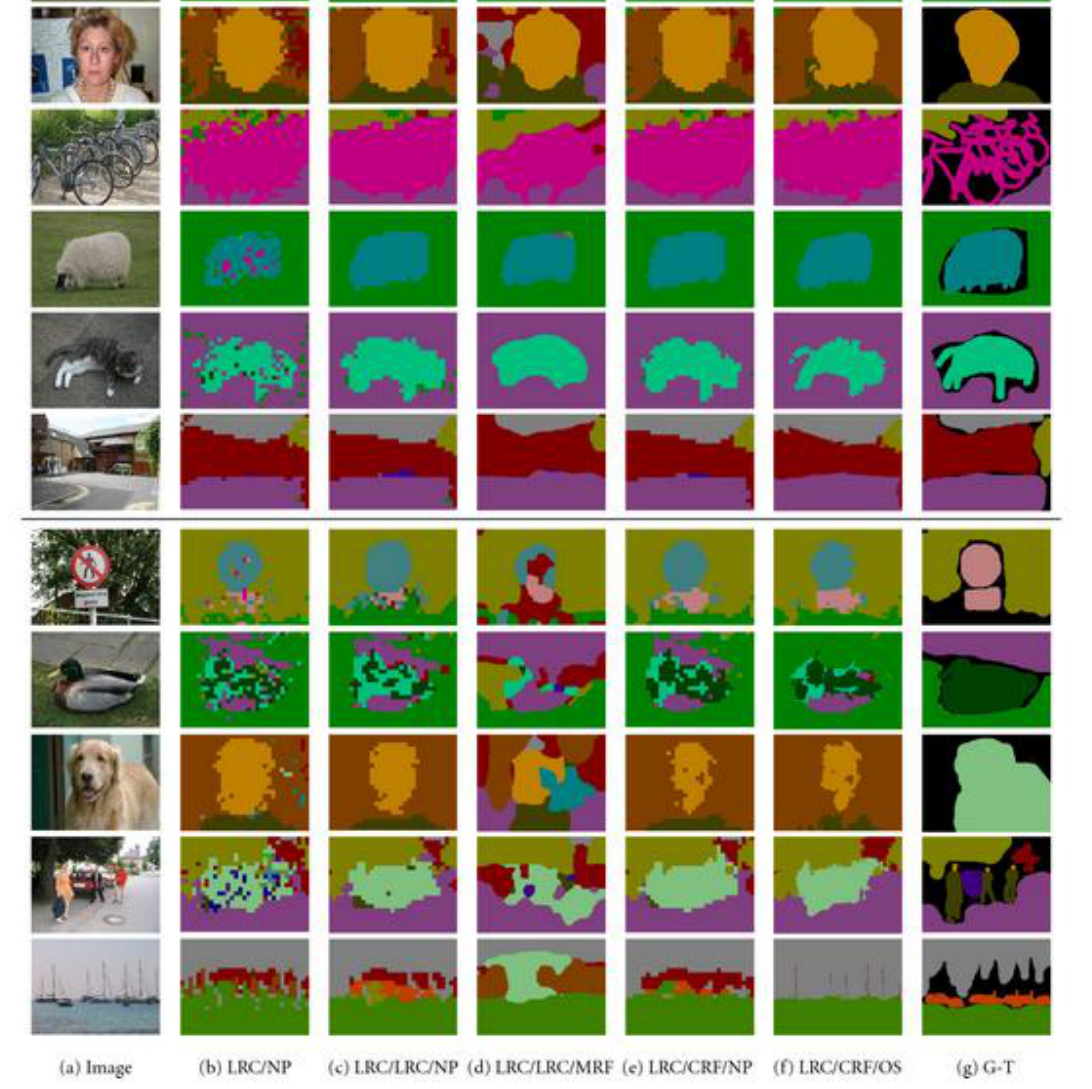
Table 2 presents the overall confusion matrix on MSRC-21 for our LRC/CRF method with oversegmentation- based refinement, using the data partition of [7]. The values reported are the percentage of image pixels assigned to the correct class, ignoring all pixels labeled as void in the ground truth. As expected, higher accuracies are obtained for visually uniform classes with large training samples (grass, sky, tree, etc.) and lower ones for classes with high variability and small training samples (boat, bird, dog, sign, body,